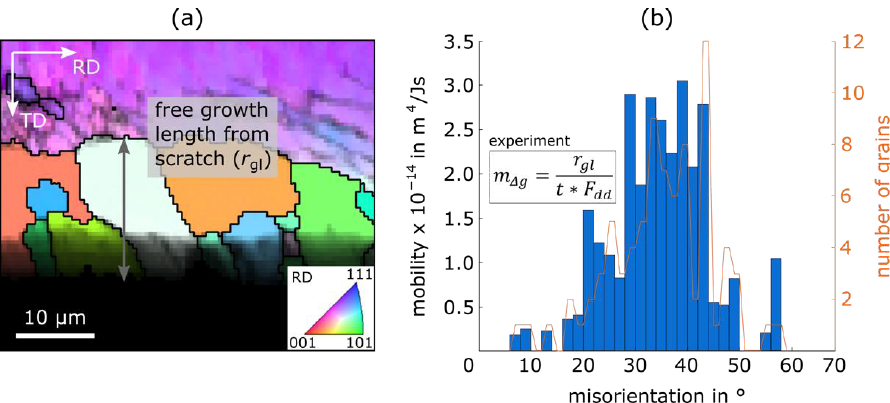
Figure 16. ( a ) Exemplary section from an EBSD panorama image heat-treated at 765 ◦ C for t = 300 s, with one free growth length r gl from the scratch drawn in, coloured according to an IPF || RD and ( b ) results of experimental grain boundary mobility calculations (plus equation) based on over 80 grains divided into misorientation classes ∆ g , with a width of 2 ◦ . IPF—inverse pole figure. Text